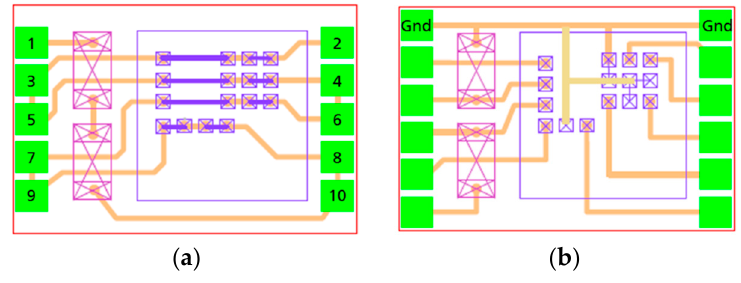
Figure 4. Package layout; ( a ) daisy chain package, ( b ) functional.